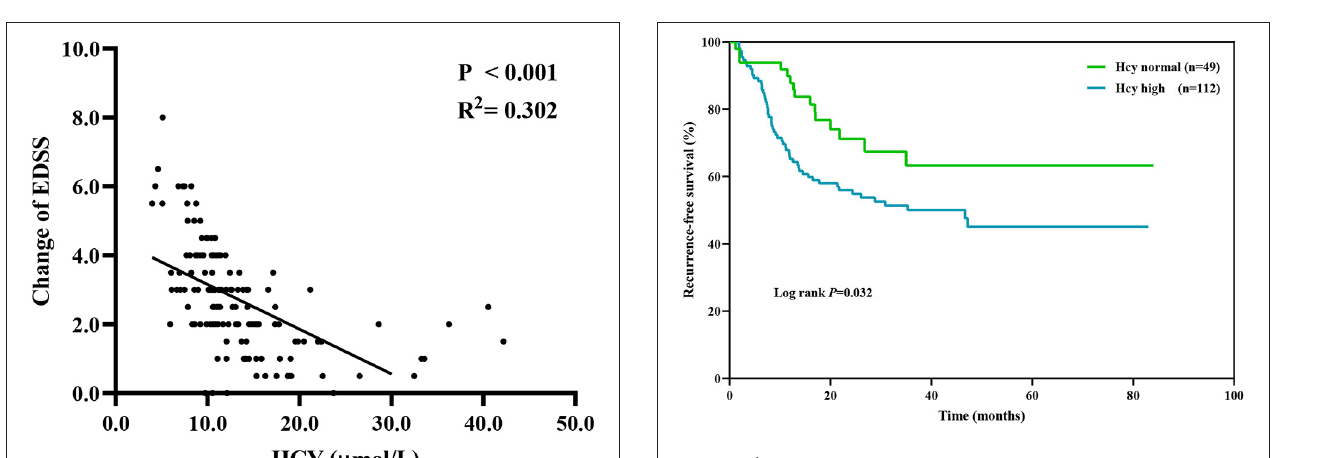
FIGURE 3 | Kaplan–Meier analysis demonstrating the cumulative proportion of patients without relapse. Hcy, homocysteine. Predictors Associated With Relapse in Patients With First-Attack